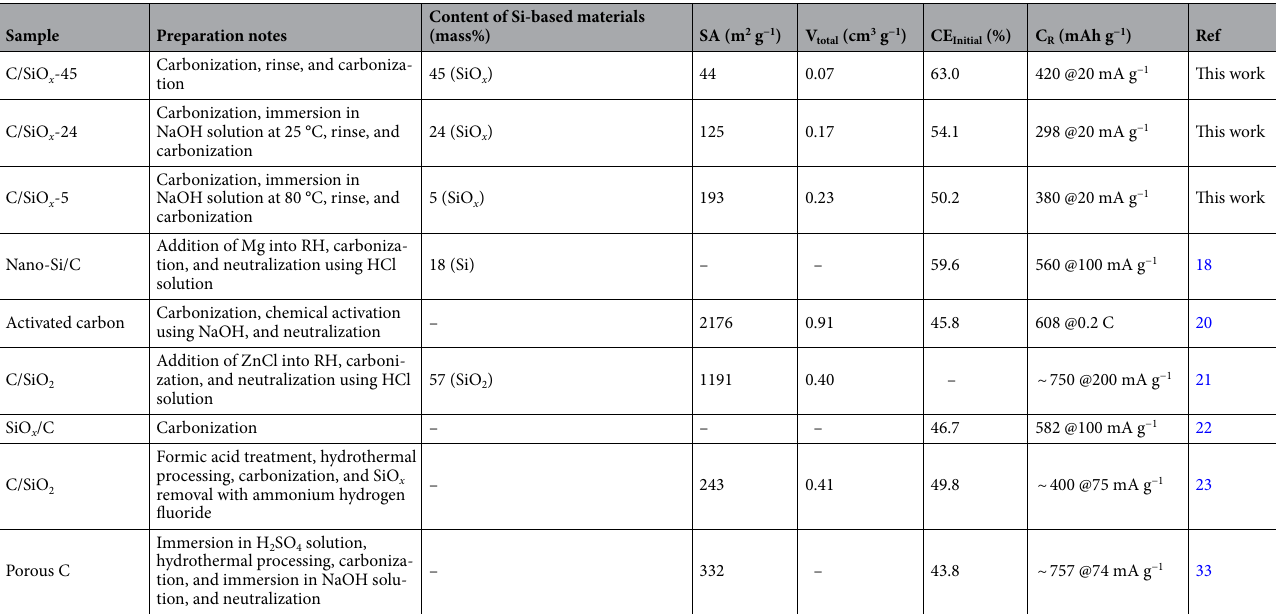
Table 3. Comparing the textural and electrochemical properties of RH-derived AMs intended for the in LIB anodes. SA: specific surface area, V total : total pore volume, CE Initial : initial Coulombic efficiency, C R : reversible specific